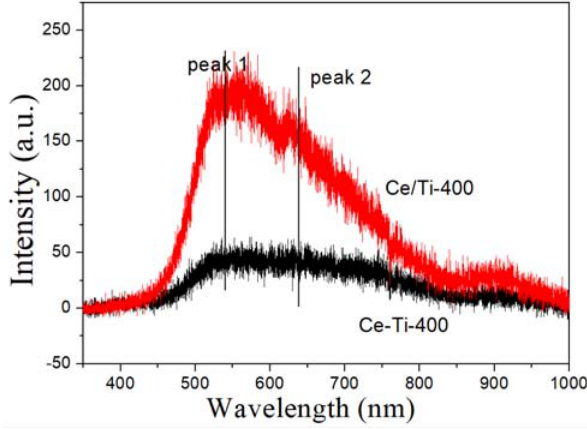
Figure 5. PL spectrum of Ce-Ti-400 and Ce/Ti-400.